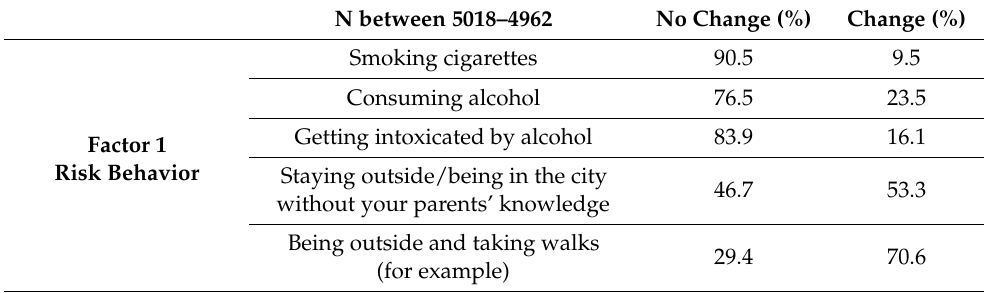
Table 1. Responses about adolescents’ behavior change comparing frequencies before and after the COVID-19 outbreak.